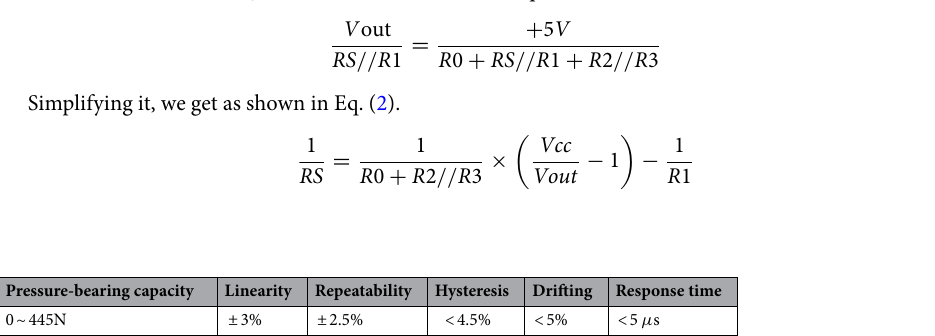
Table 2. FlexiForce A201 performance